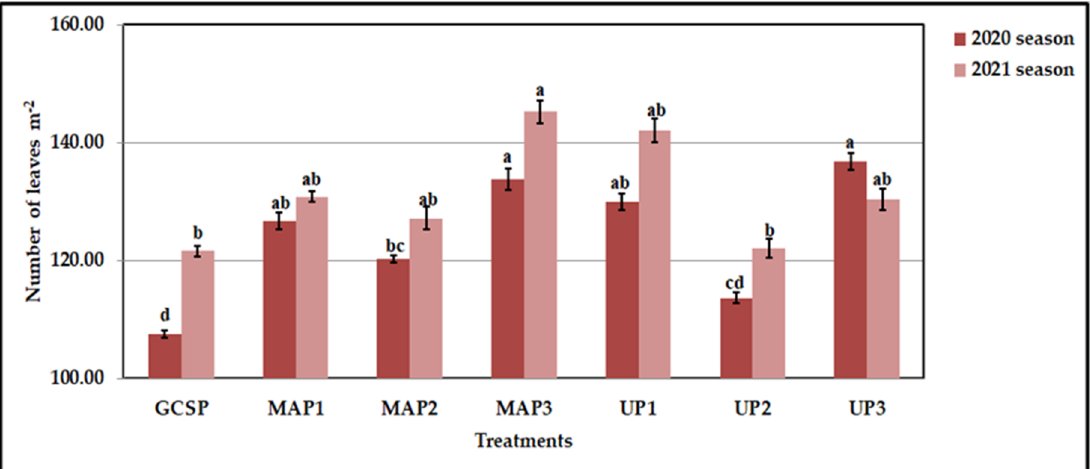
length (ShL, cm) of olive (arbequina cv.) trees grown in sandy loam clay soil under multi-abiotic stresses (CaCO 3 = 8.8 vs. 9.2%, ECe = 6.4 vs. 7.2 dS m − 1 , and pH = 7.78 vs. 7.89) during 2020 and 2021 seasons. GSCP applied represents 1.75 kg tree − 1 , MAP 1 , MAP 2 , and MAP 3 represent MAP applied at 0.336, 0.445, and 0.555 kg tree − 1 , and UP 1 , UP 2 , and UP 3 represent UP applied at 0.465, 0.616, and 0.770 kg tree − 1 . Bars in the same years with a different letter indicate significant differences between treatments at p ≤ 0.01. According to Duncan’s multiple range test, bars sharing the same letter in each column are not signi fi cantly different .